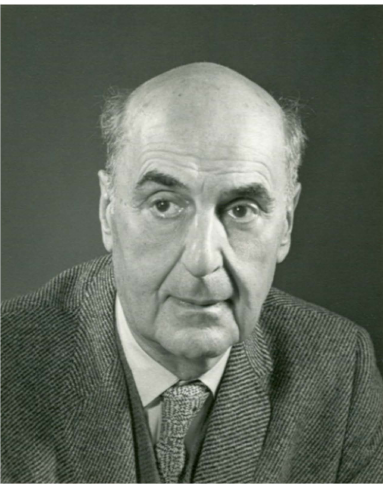
Figure 1. L á szl ó Zechmeister, 14 May 1889 (Gy˝or, Hungary)—28 February 1972 (Pasadena, CA,